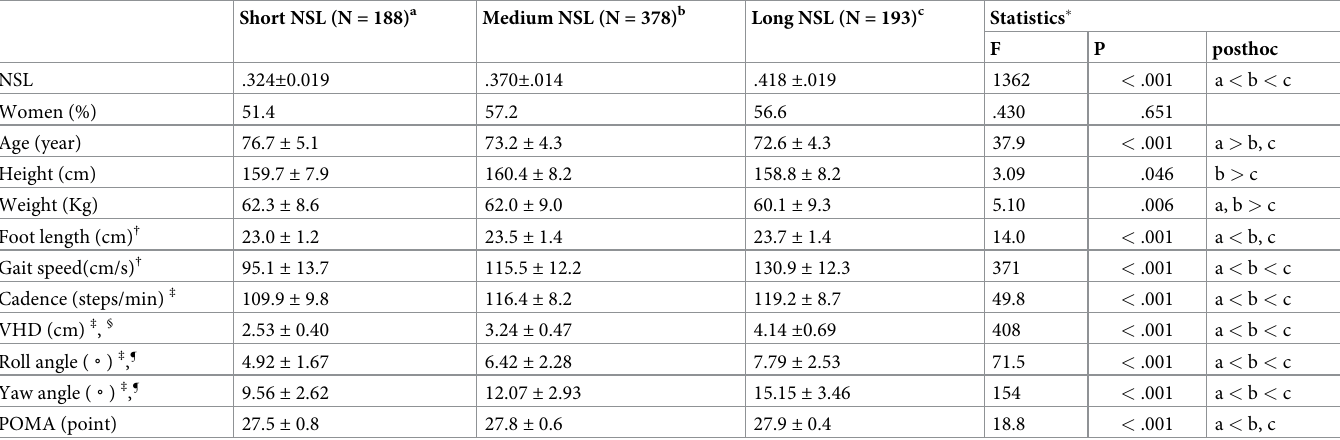
Table 2. Characteristics of the subgroups classified by normalized step